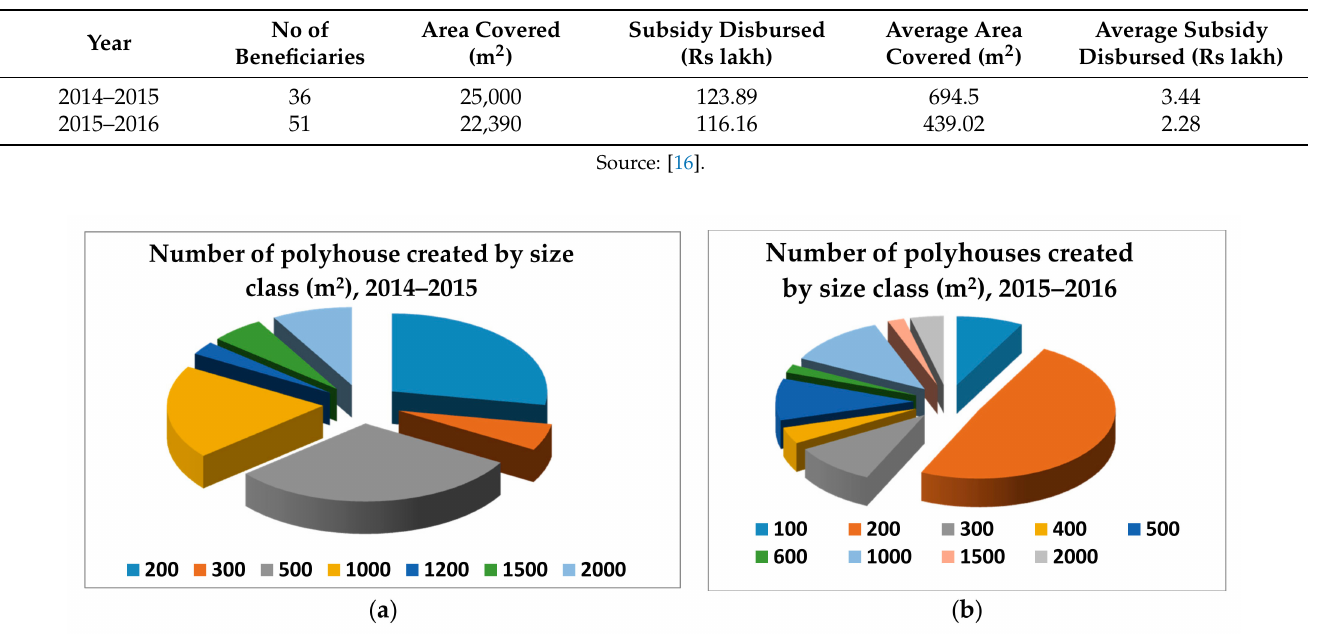
Table 5. Performance of HMNEH